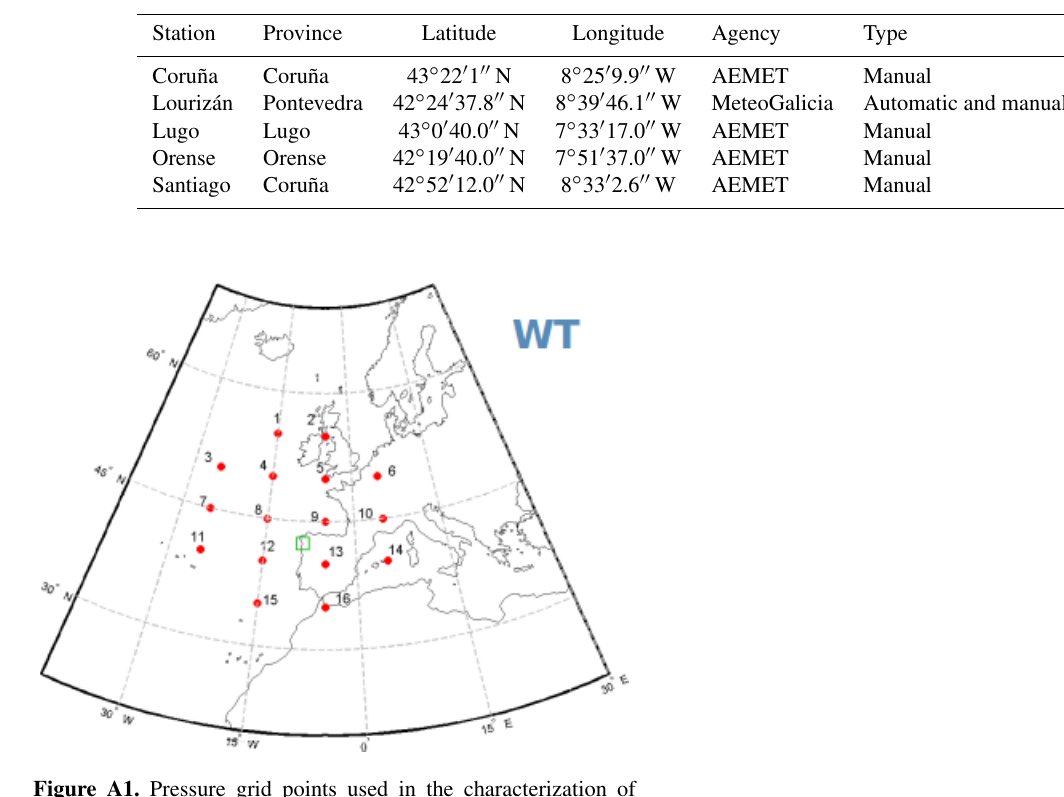
Table A1. Information regarding the meteorological stations.